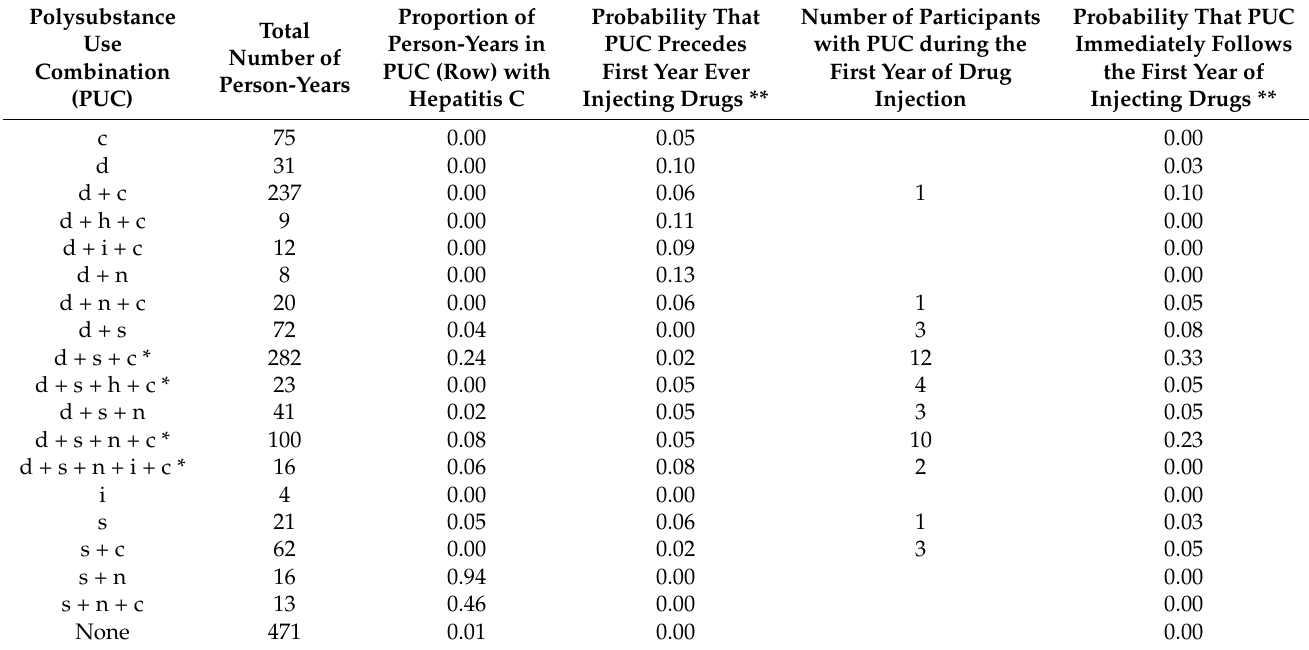
Table 4. Probability state transition values for substance use sequences relative to first injection event in an unbalanced panel of Assiniboine and Sioux people who use injection drugs, n = 1513 person-years for 40